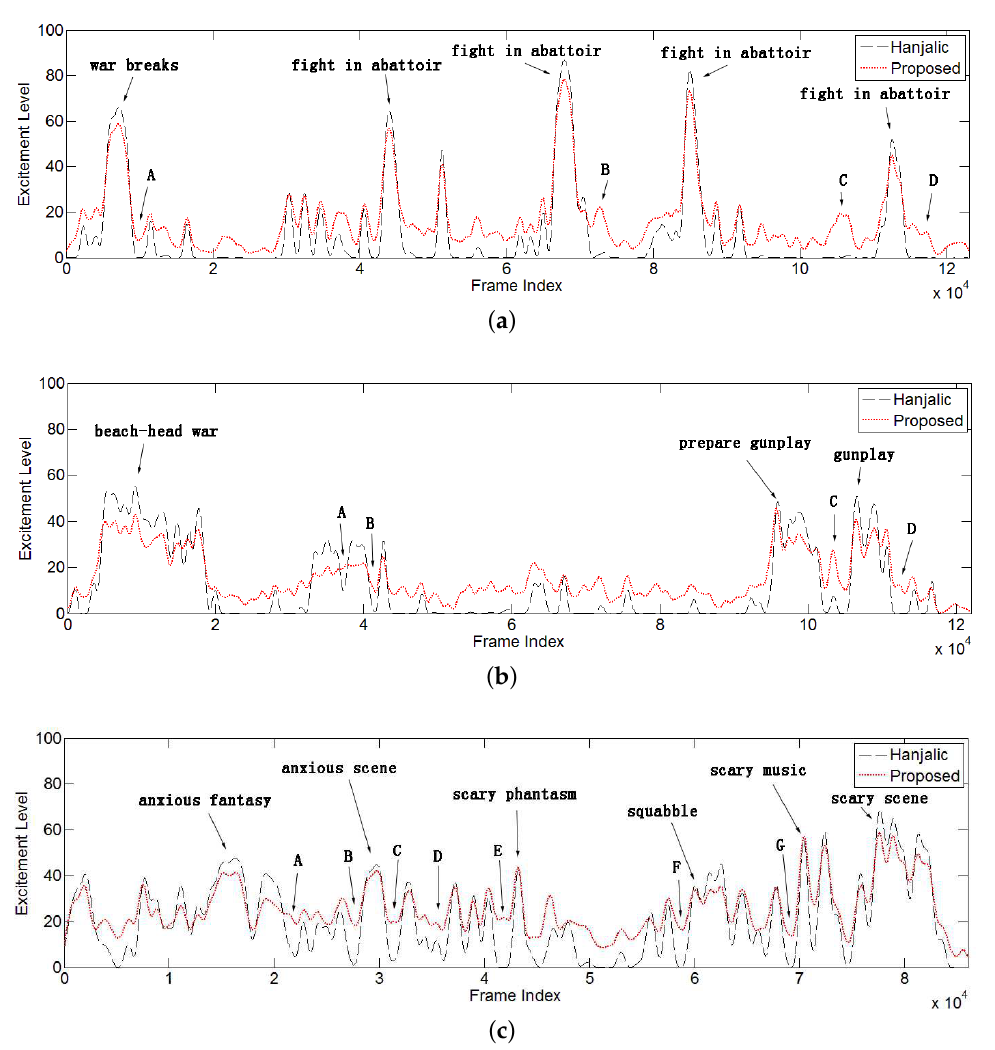
Figure 8. Excitement time curves extracted from three films including “Gladiator” ( a ), “Saving Private Ryan” ( b ), and “The Shining” ( c